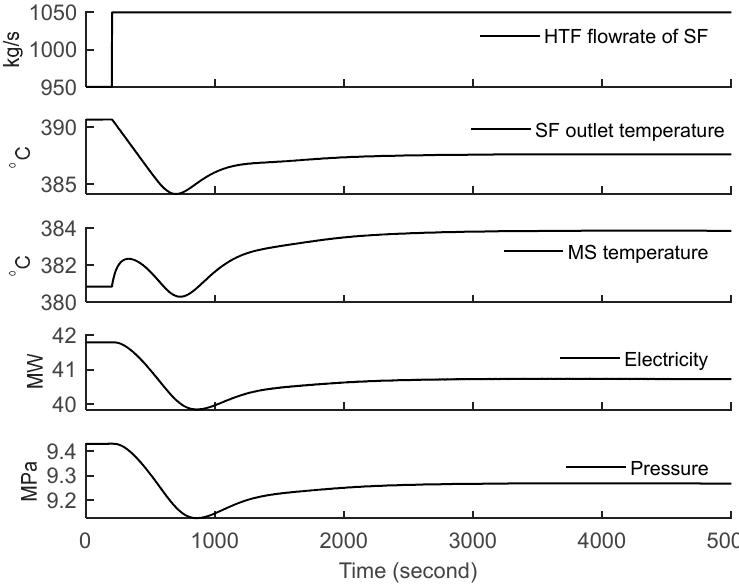
Figure 2. System response to step change of HTF flowrate of SF.